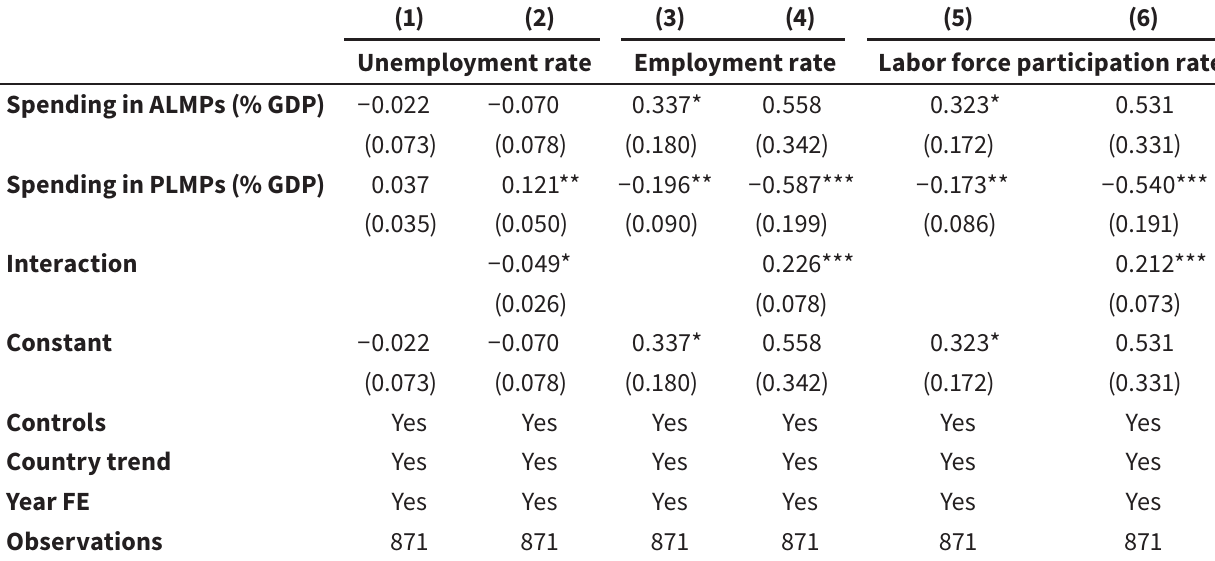
Table 5. Results for the robustness test including additional